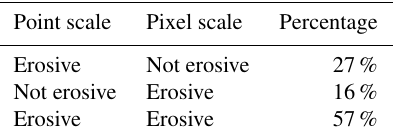
Table 2. Percentage of cases that were erosive at point (115 rain gauges) or pixel scale (115 radar pixels) relative to a total of 35124 point–pixel pairs of rain events that were erosive on at least one of both scales. Point scale Pixel scale Erosive Not erosive 27% Not erosive Erosive 16% Erosive Erosive 57%